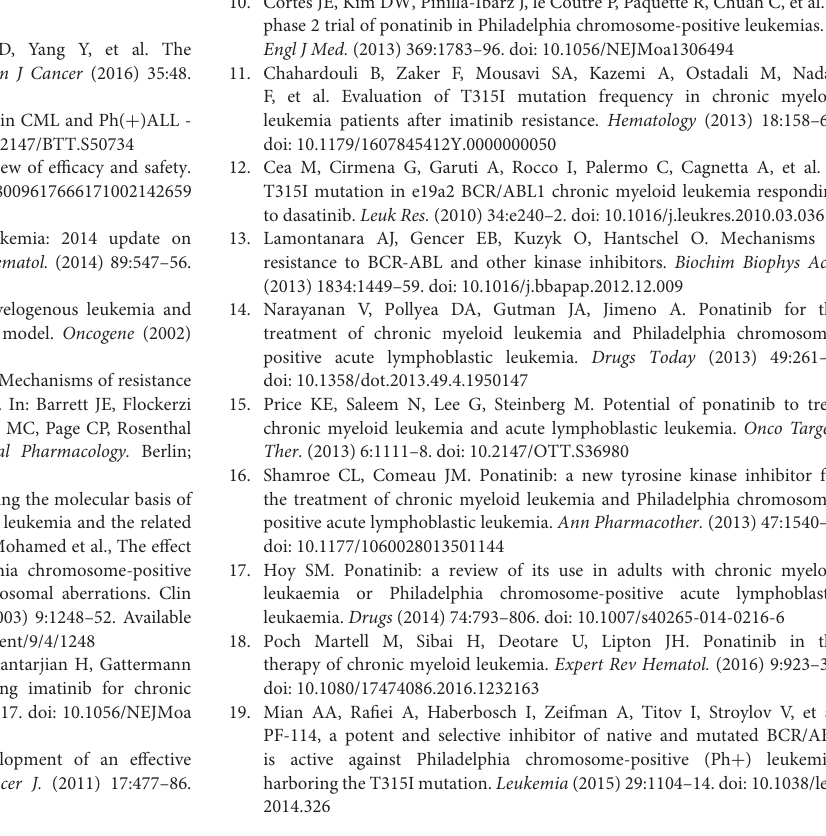
Supplementary Figure 1 | Ponatinib-mediated ERK5-S496 phosphorylation in endothelial inflammatory responses. (A) Expression of phospho-ERK5 at S496, ERK5, phospho-p90RSK at S380, and p90RSK in HAECs treated with ponatinib (150nM) was assessed by Protein simple WES system (capillary electrophoresis western analysis). Protein bands are shown as pseudoblots. (B) qRT-PCR analysis of relative tnf expression in HAECs expressing ERK5-WT or S496A mutant treated with ponatinib (75nM, 24h). Data set contains 6 technical replicates. Error bars represent mean ± SEM. Statistical significance was assessed using ANOVA followed by Bonferroni post hoc testing for multiple group comparison. ∗∗∗ P < 0.001 vs. control. (C) Flow cytometric analysis of Annexin V staining in HAECs expressing ERK5-WT or S496A mutant treated with ponatinib (150nM, 24h). Graph shows percentage of apoptotic cells. Data set contains 3–6 technical replicates. Error bars represent mean ± SEM. Statistical significance was assessed using student’s t -test (two-tailed). ∗∗∗ p <